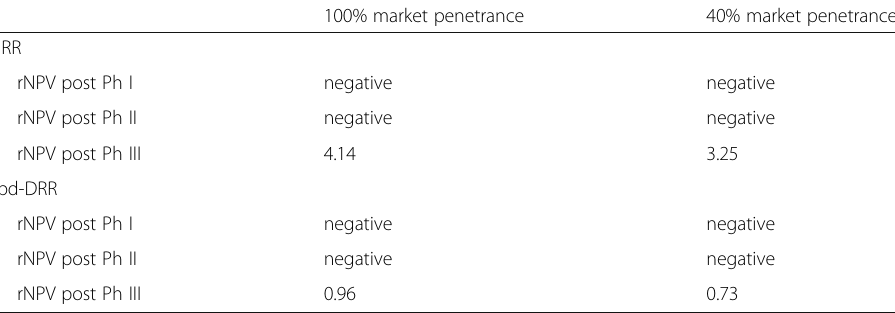
Table 9 The small company perspective and the impact of geopolitical changes and the risk of not being able to access large trading blocks, on values. (values indicated in $mn, using the latest success